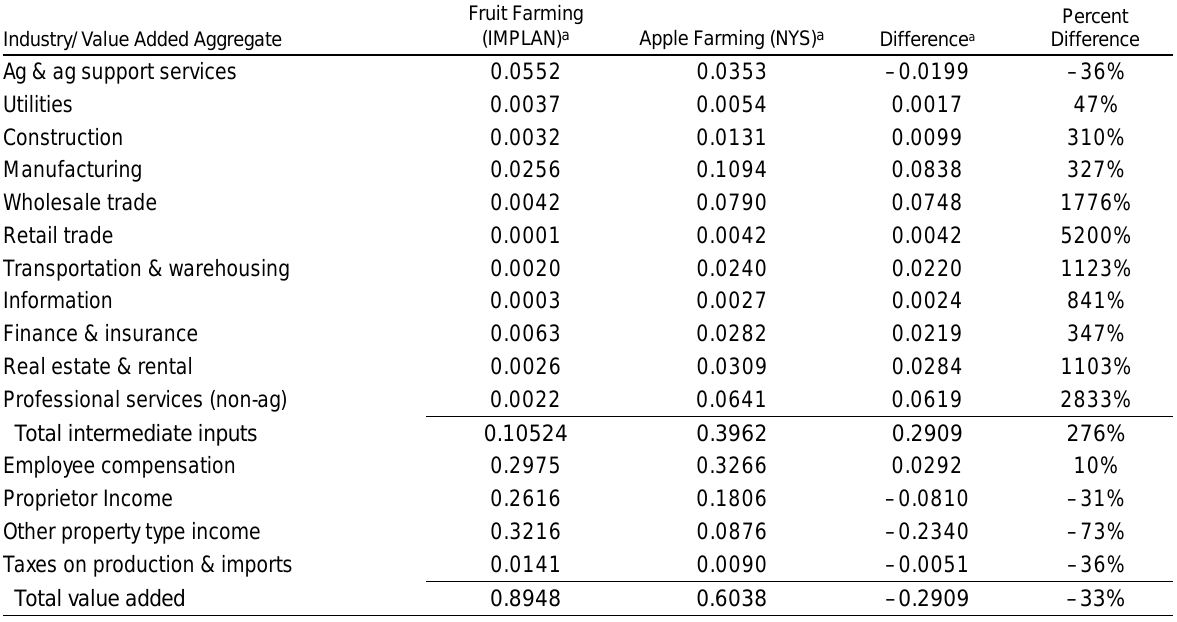
Table 2. Apple Farming Production Function in New York State Compared to Fruit Farming Production Function in